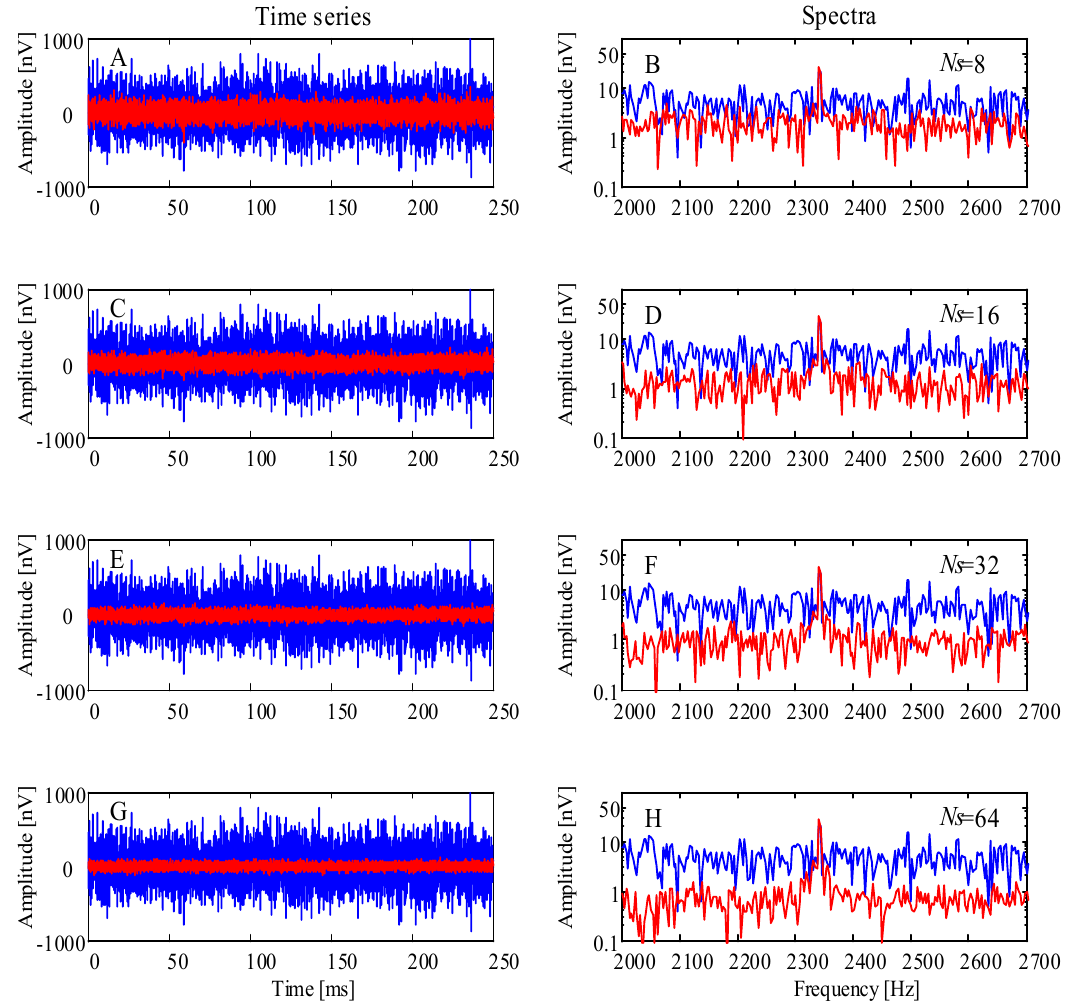
Figure 10. Simulation case: Time-series and spectra of 8, 16, 32, 64 stacks at one pulse moment, Simulation case: Time-series and spectra of 8, 16, 32, 64 stacks at one pulse respectively. moment,